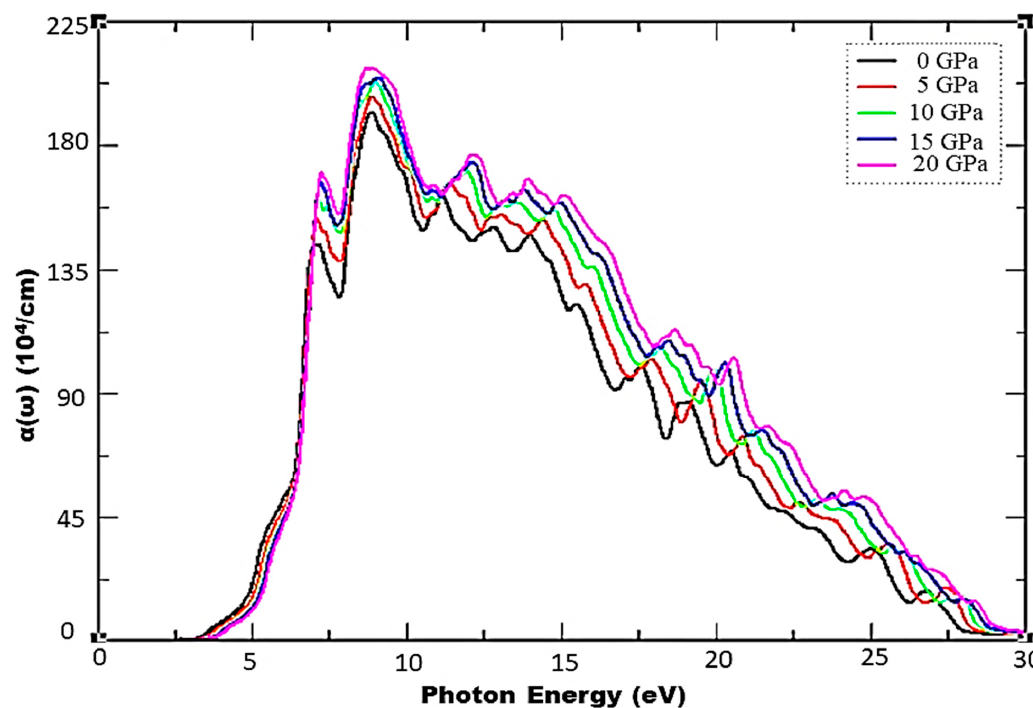
Figure 6. Pressure-induced variations in absorption.